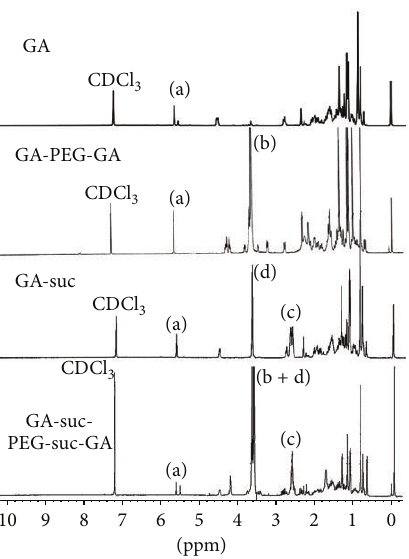
Figure 2: 1 H NMR spectra of GA and GA-PEG-GA and GA-suc- PEG-suc-GA.